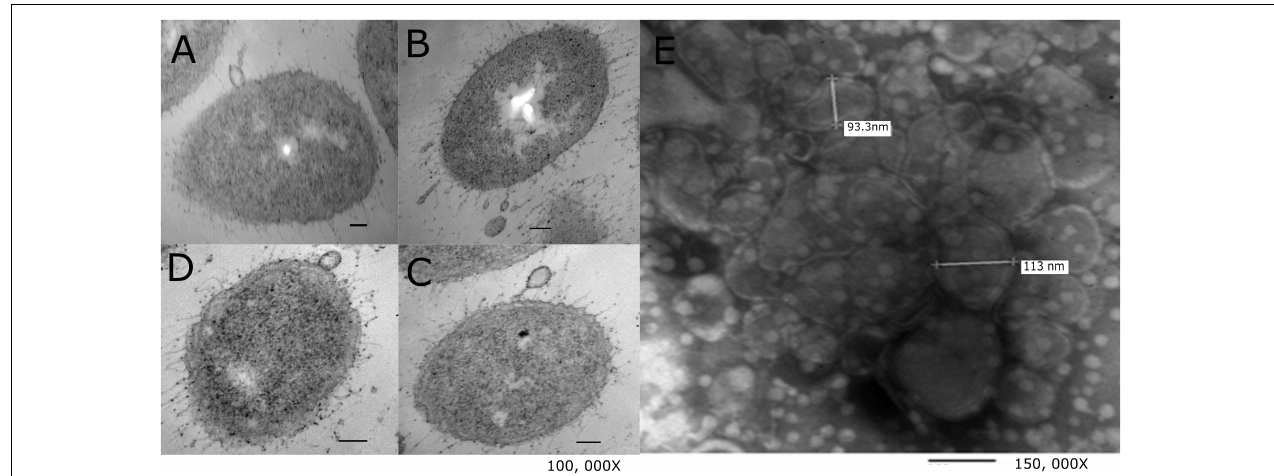
FIGURE 1 | Electron microscopy of A. hydrophila ATCC R (cid:13) 7966 TM OMVs. (A–D) Agar embedded whole bacteria was processed for thin section and negative stained with OsO 4 ; in the micrographs OMVs are pinch off from the bacterial surface (magnification 100, 000 × ). (E) Purified OMVs stained with fosfotungstic acid showed vesicles with a double membrane ranging in size from 90 to 100 nm (magnification 150, 000 × ). Bars = 100 nm.